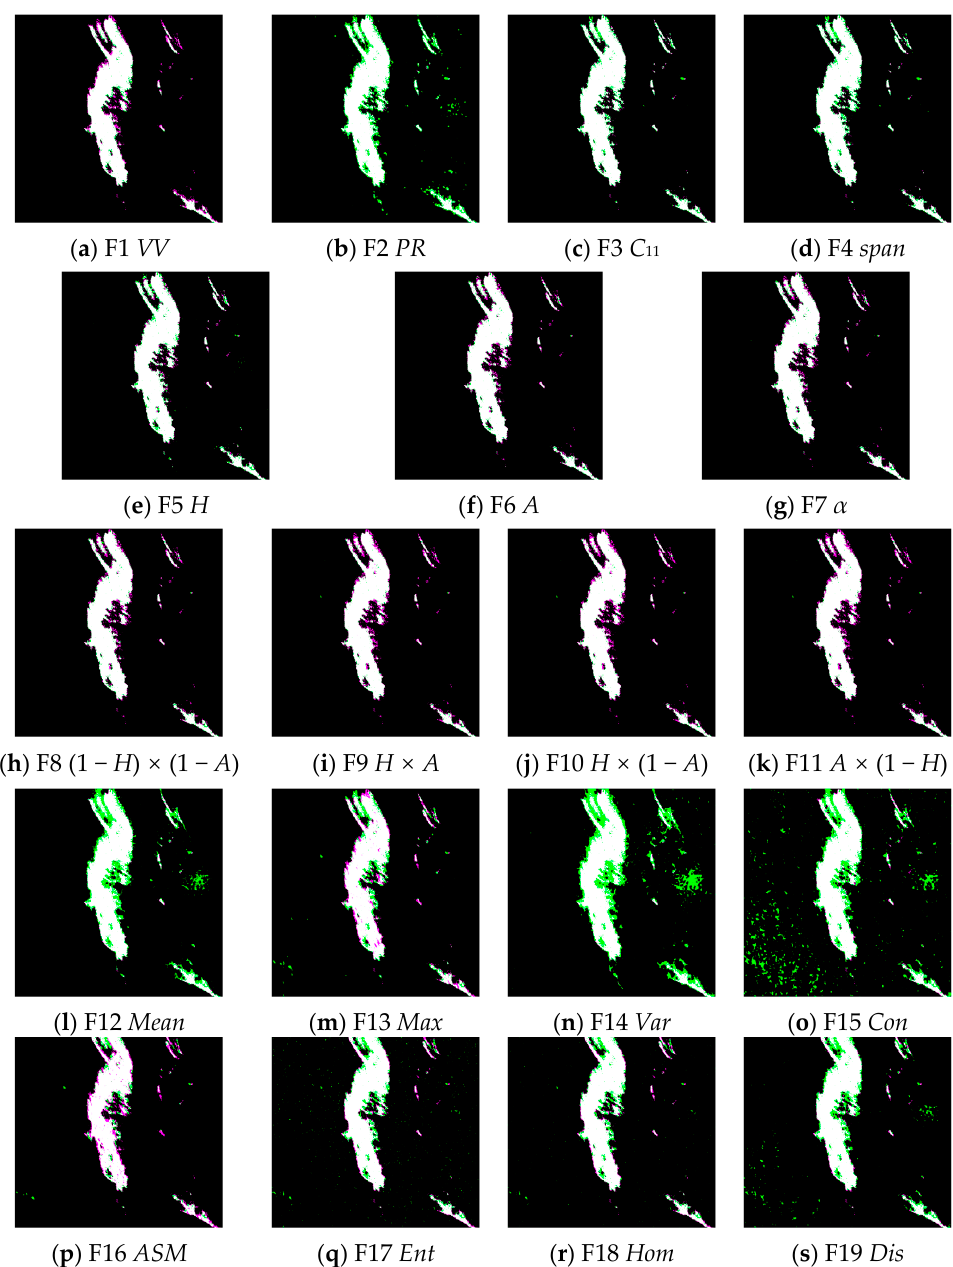
Figure 13. Evaluation results for data b based on J–M/K-means algorithm.